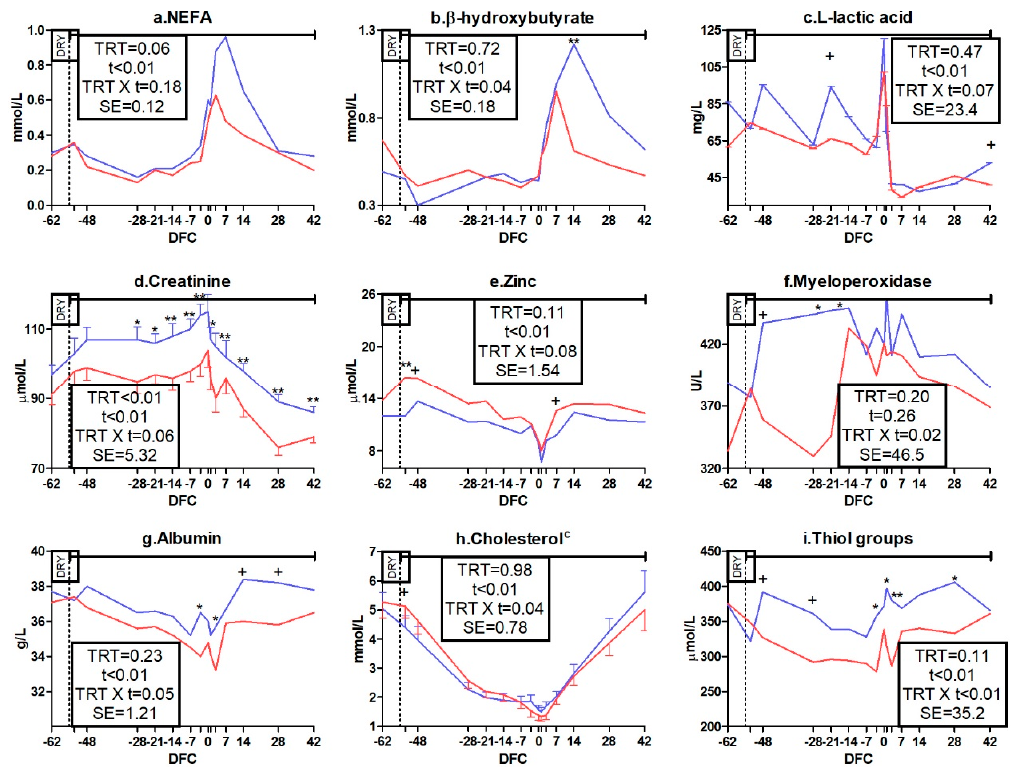
Figure 3. Time course of plasma concentrations of non-esterified fatty acids (NEFA; ( a )), β -hydroxybutyrate ( b ), L-lactic acid ( c ), creatinine ( d ), zinc ( e ), myeloperoxidase ( f ), albumin ( g ), cholesterol ( h ), and thiol groups ( i ) in control dairy cows (CTR; blue line, n = 5) and cows receiving 65 g*d − 1 of Omnigen-AF ® as top-dress (IMS; red line, n = 5) between − 55 and 42 days from calving. Upper solid line indicates timing of treatment administration. TRT is treatment effect; t is time effect; TRT × t is the treatment × time interaction effect (** is p < 0.01; * is p < 0.05; + is p < 0.10). DFC is days from calving; DRY is dry-o ff day ( − 55 days from expected calving); SE is standard error; c Parameter was covariate on − 62 value.